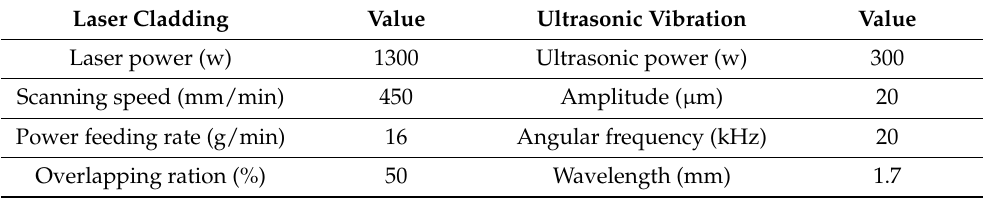
Table 2. The process parameters used in preparation of